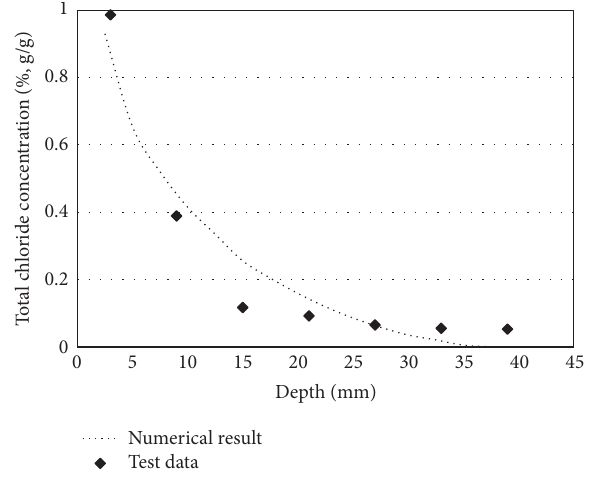
Figure 11: A comparison between numerical result and test data at 12 days of a specimen exposed to 𝑇 = 35 ∘